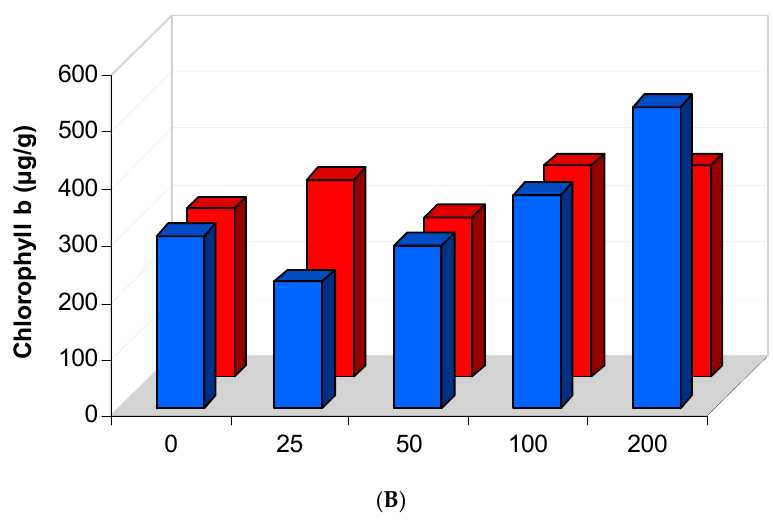
Figure 10. Photosynthetic pigment content in cucumber and tomato under salinity stress. Total chlorophyll a ( A ) and chlorophyll b ( B ).